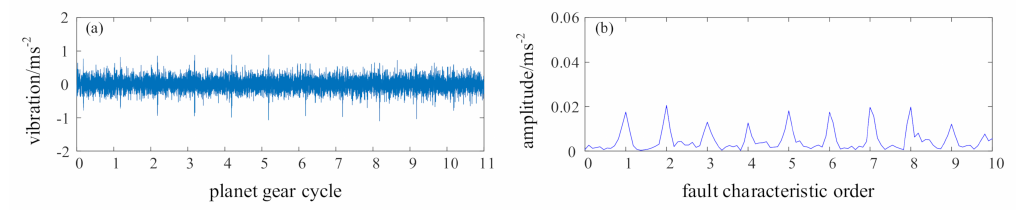
Figure 14. CVS signal: ( a ) signal waveform; ( b ) envelope order spectrum.